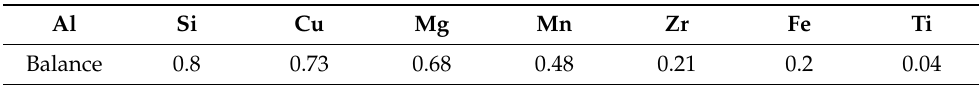
Table 1. Chemical composition (wt.%) of the alloy obtained through optical emission spec- troscopy